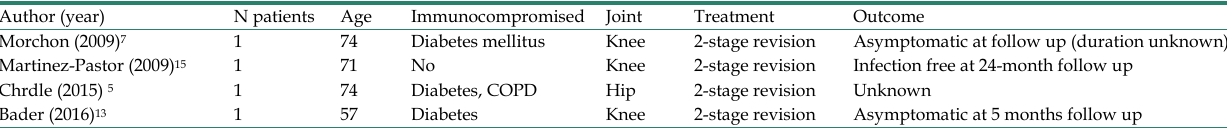
Table 1. Literature review Author